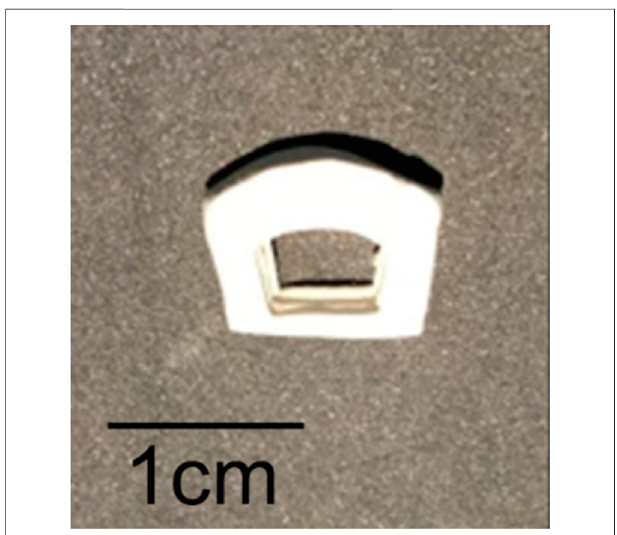
FIGURE 2 | Photos of the 3D-printed cervical interbody fusion